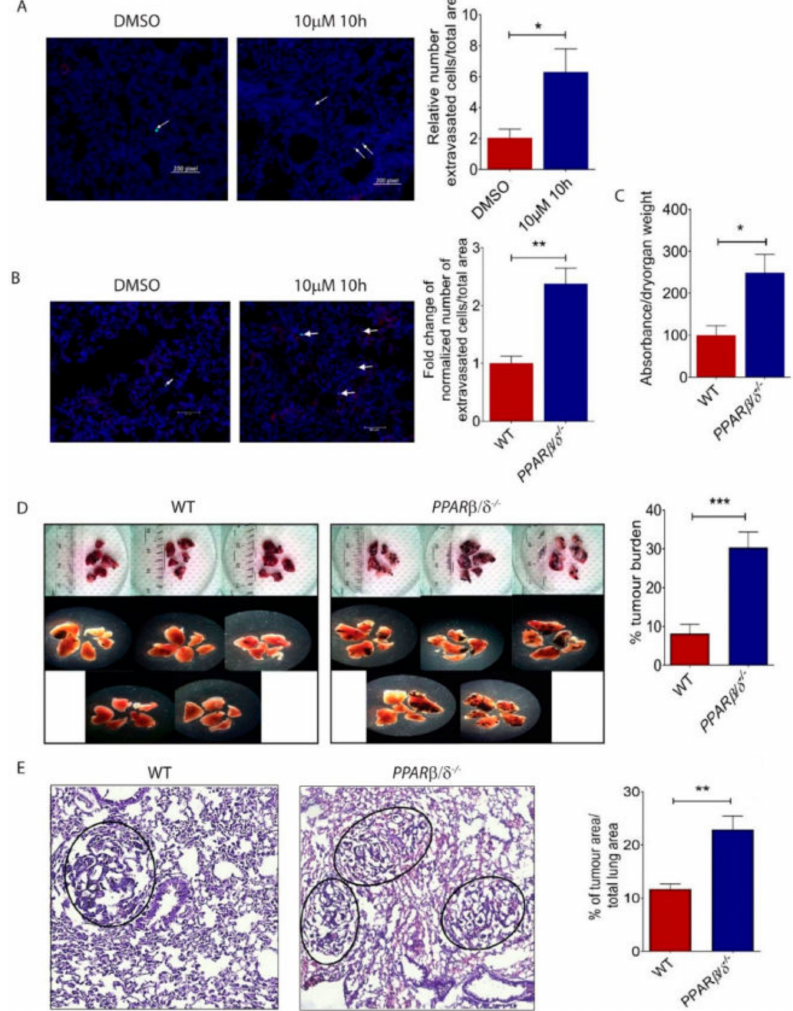
Figure 4. PPAR β / δ inhibition promotes pulmonary lung metastasis of B16/F10 melanoma cells. ( A ) Representative images and quantitative analysis of extravasated B16/F10 cells in C57BL/6 mice subjected to intravenous delivery of 10h- or vehicle-treated B16/F10 cells ( n = 3). ( B ) Representative images and quantification of extravasated B16/F10 cells in the lungs of wild type ( n = 6) or Ppar β / δ − / − mice ( n = 7). Scale bar: 60 µ m. Arrows indicate extravasated tumour cells. ( C ) Quantification of Evans blue dye extravasation in the lungs of wild type ( n = 4) and Ppar β / δ − / − ( n = 4) 30 min after Evans blue injection. ( D ) Representative images and quantification of the metastatic burden in the lungs of wild type ( n = 8) and Ppar β / δ − / − mice ( n = 8) subjected to intravenous delivery of B16/F10 cells. ( E ) Representative images and quantification of Hematoxylin & Eosin staining showing metastatic tumour nodules in the lungs of wild type ( n = 5) and Ppar β / δ − / − mice ( n = 5). All images are representative. Data are presented as the mean ± s.e.m. Significance was determined by two tailed, unpaired, Student’s t -test; * p < 0.05; ** p < 0.01; *** p <